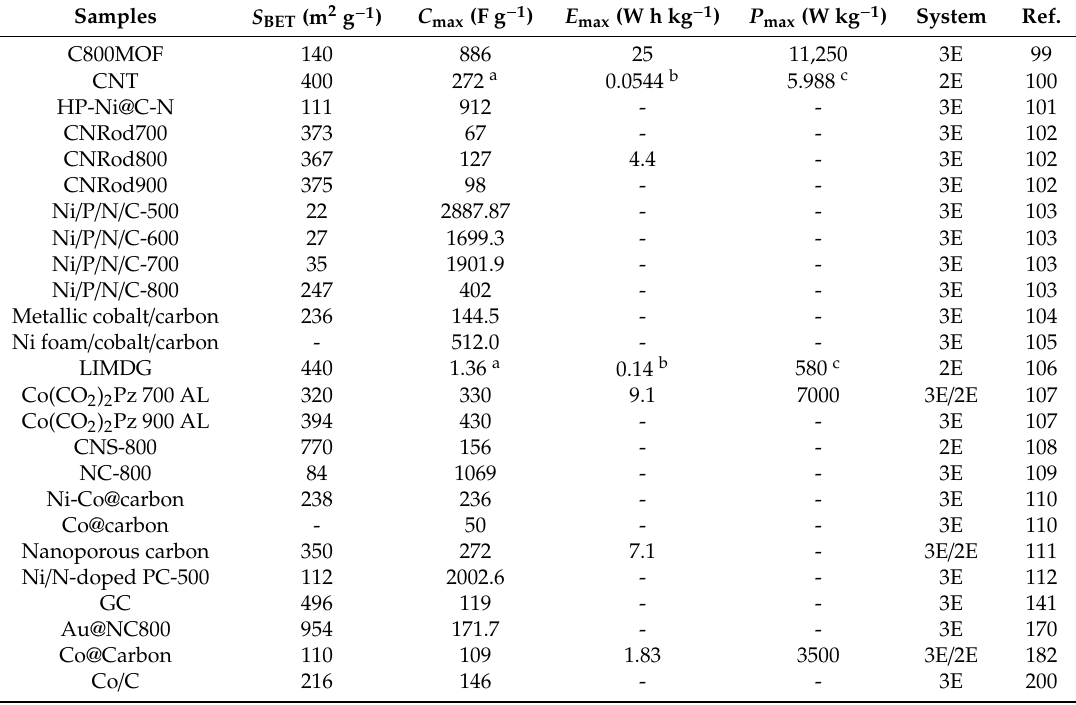
Table 6. The electrochemical capacitive performances of metallic NP-containing carbons derived from